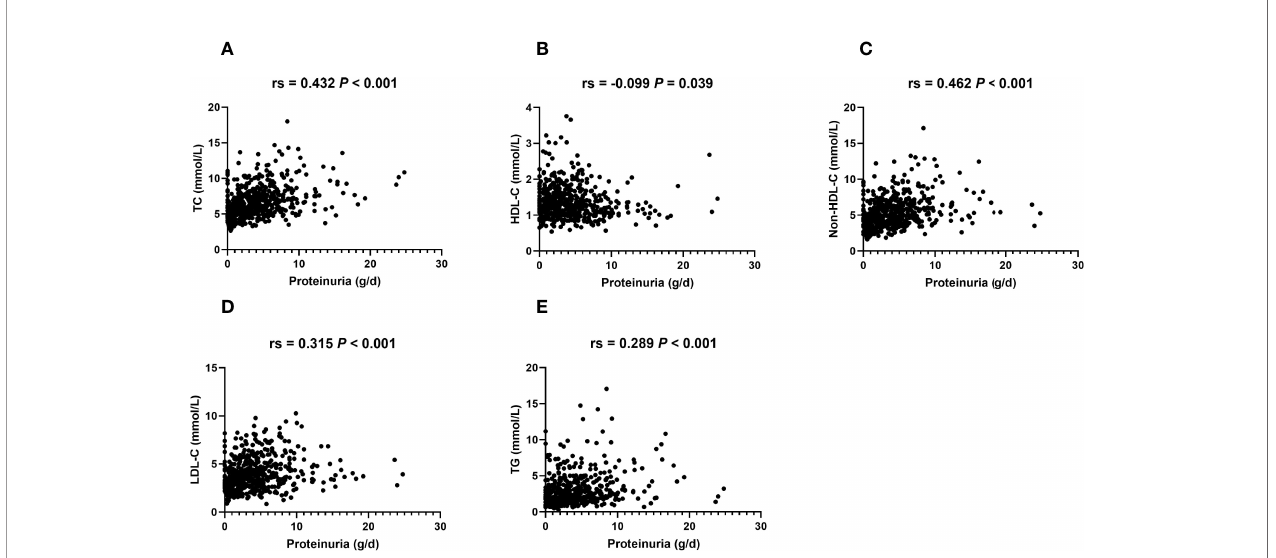
FIGURE 3 | Serum lipid levels are related to proteinuria in IMN patients. Bivariate scatterplots relating proteinuria to TC (A) , HDL-C (B) , non-HDL-C (C) , LDL-C (D) , and TG (E) , including P- values for Spearman ’ s analysis (N = 495). Rs: Spearman ’ s rank correlation coef fi cient.